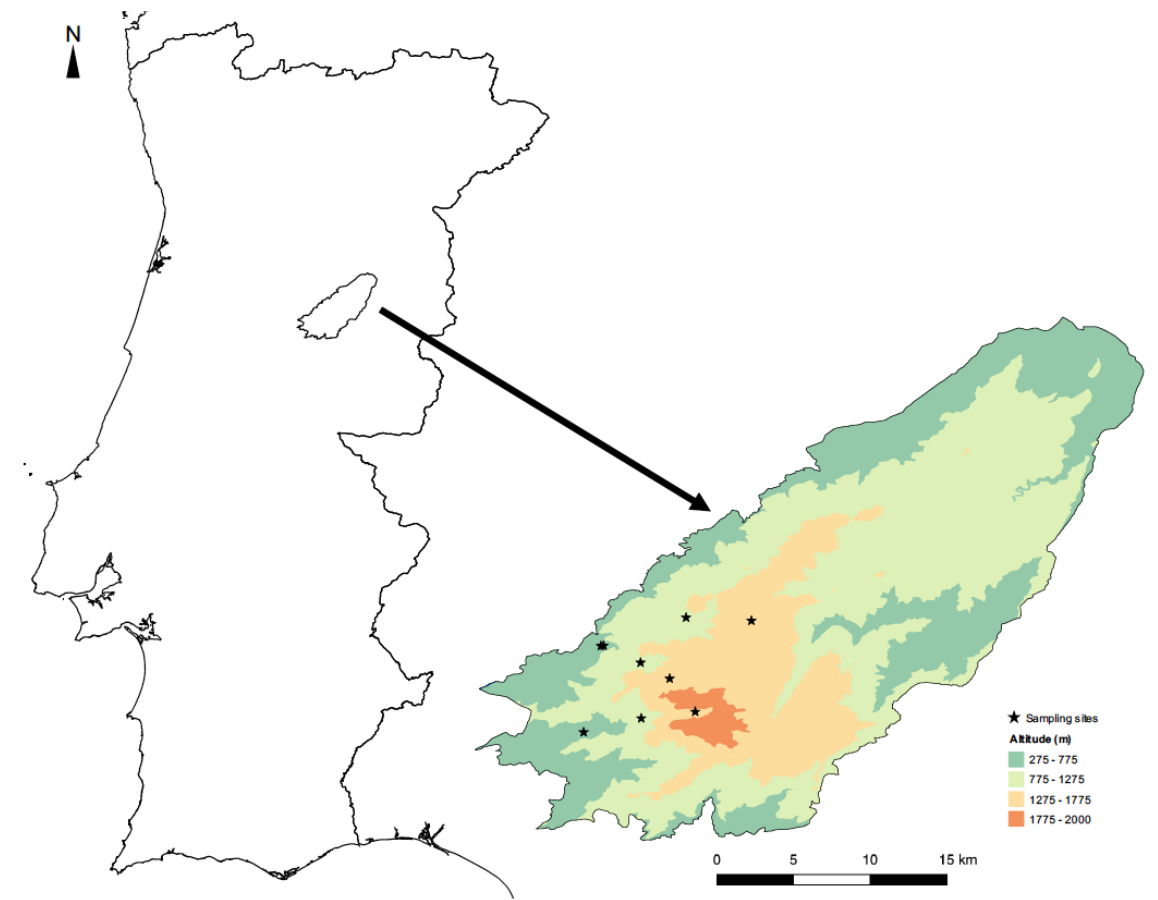
Figure 1. Location of the Serra da Estrela Natural Park in Portugal, showing the distribution of the sampling sites by elevational band in this protected area.